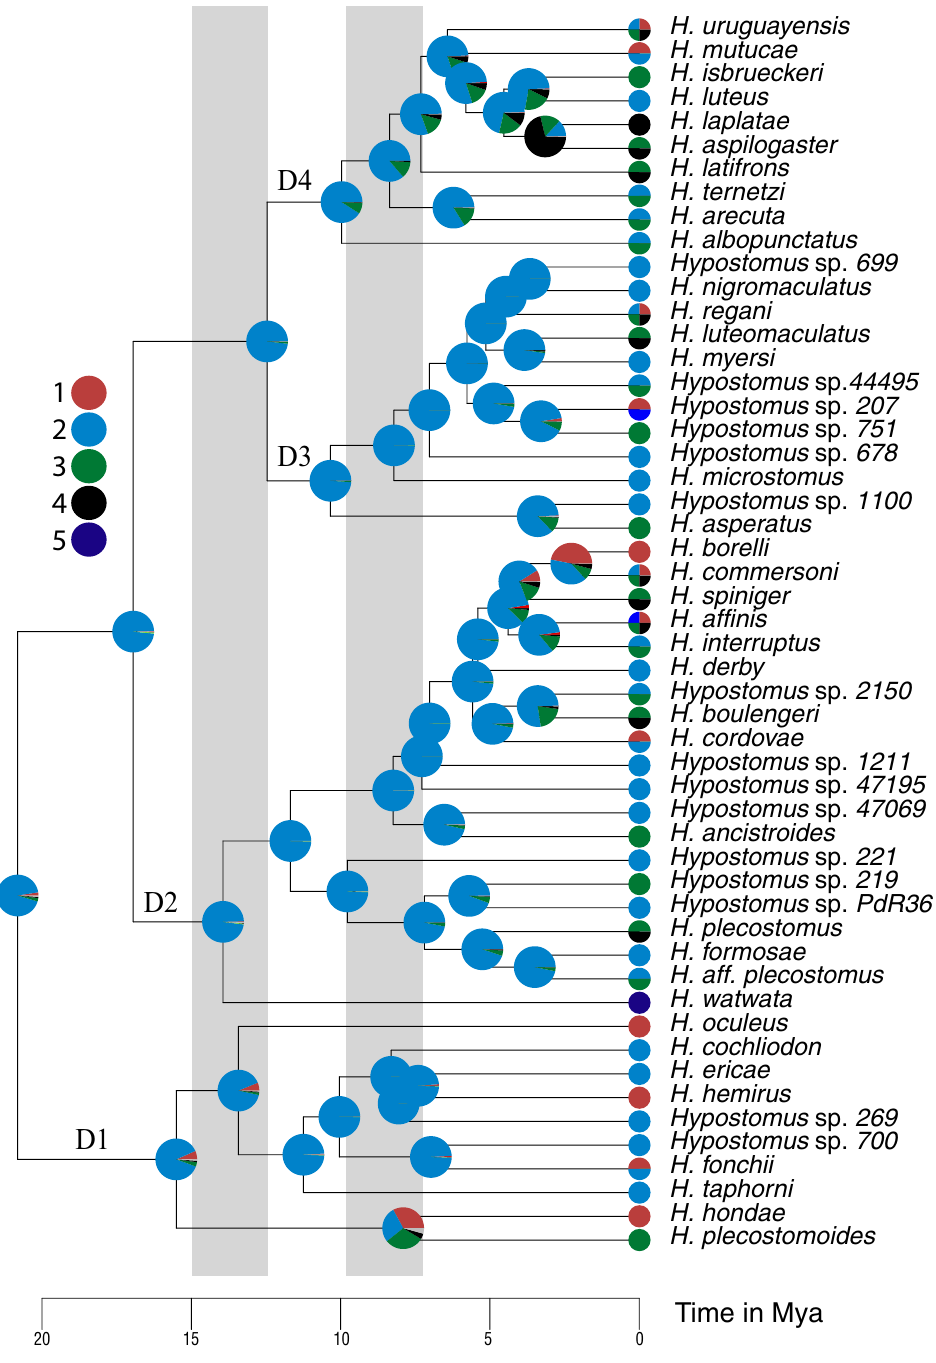
Figure 2. Time-calibrated multilocus phylogeny for the Hypostomus genus based on hydrogeological calibration points, illustrating ancestral habitat inferences performed using a maximum likelihood approach (function rayDISC of the package corHMM). Color proportion in the pie charts over the nodes reflects the likelihood of an ancestral habitat preference. In the tips, color proportion reflects the presence or absence of an extant species in a given habitat. Habitat preference codes: upland streams and small rivers in Andean piedmont (1), upland streams and small rivers in shield escarpments (2), lowland terra-firme streams and medium rivers (3), deep river channels (4), and tidal estuarine systems (5). Grey vertical bars are the maximum flooding events of the Miocene Marine